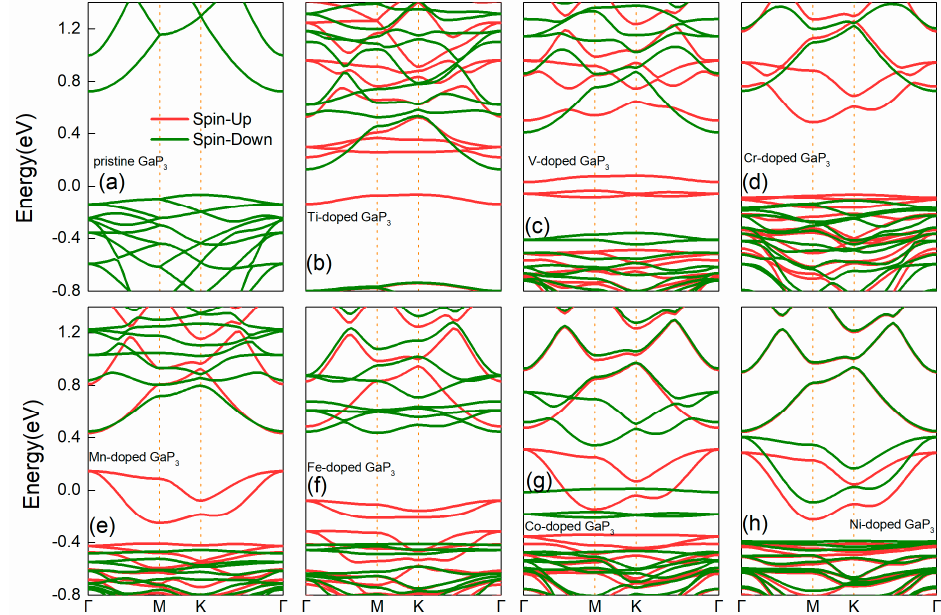
Figure 2. The electronic band structures of different doped GaP 3 systems, ( a ) pure GaP 3 , ( b ) Ti–doped GaP 3 , ( c ) V–doped GaP 3 , ( d ) Cr–doped GaP 3 , ( e ) Mn–doped GaP 3 , ( f ) Fe–doped GaP 3 , ( g ) Co–doped GaP 3 and ( h ) Ni–doped GaP 3 , respectively.